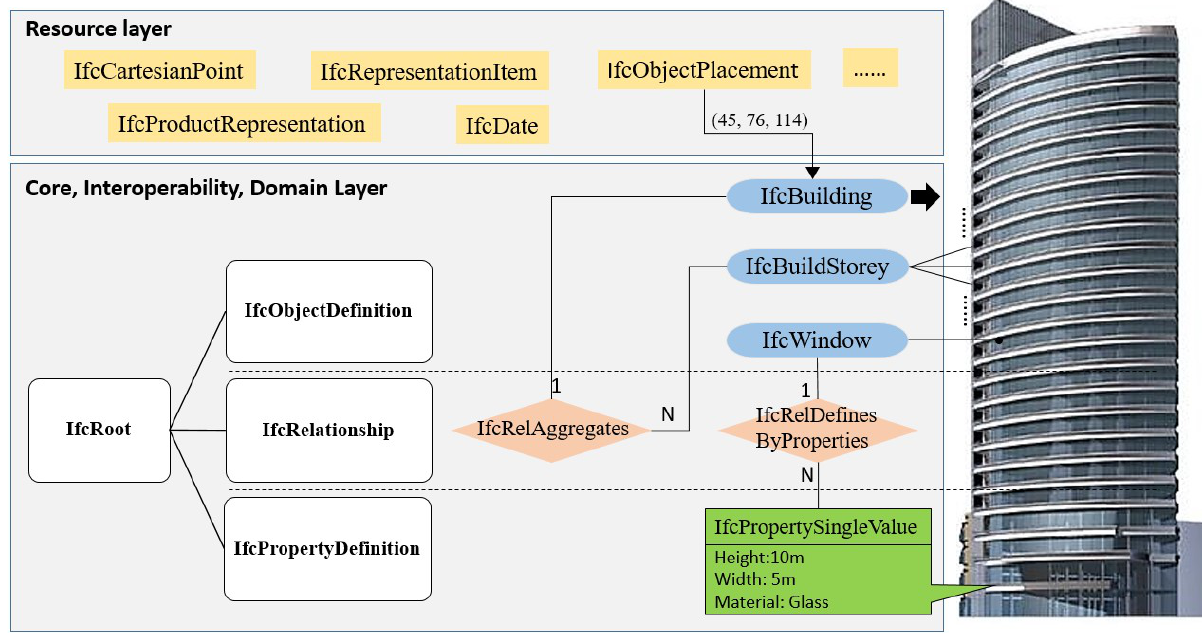
Figure 1. Expressing a building in IFC